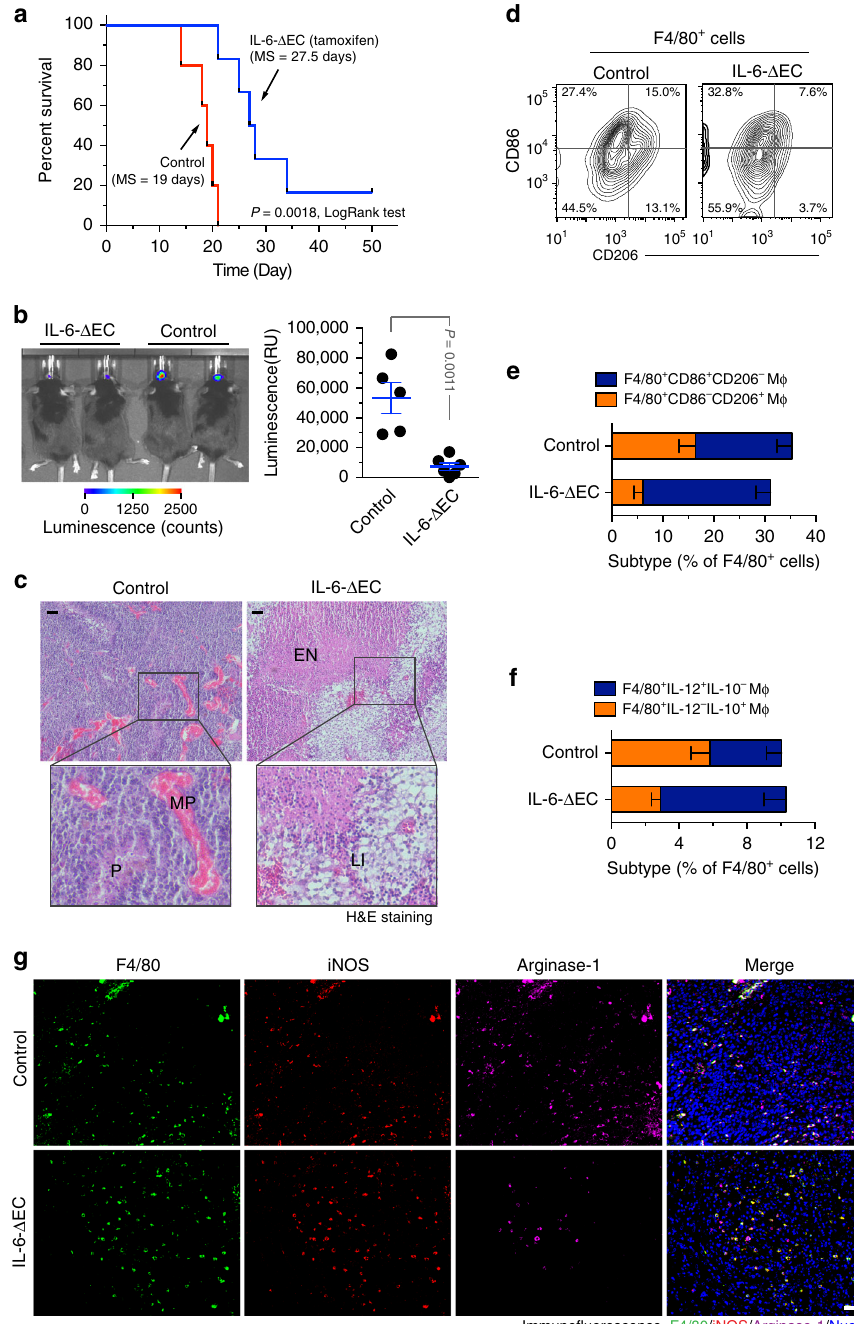
Fig. 8 Endothelial IL-6 is critical for macrophage alternative activation and GBM growth and progression. The genetically engineered GBM model was induced in Ntv-a ; Ink4a-Arf − / − ; Pten − / − ; LSL-Luc donor mice, followed by orthotopic tumor implantation into Cdh5 - Cre ERT2 ; Il6 fl / fl mice that were treated with (IL-6- Δ EC) or without (Control) tamoxifen. a Animal survival was monitored for 50 days post-injection ( n = 5 – 6 mice, one representative result from three independent experiments). P values were determined by log-rank (Mantel – Cox) tests. MS, median survival. b Tumor growth was analyzed by bioluminescence. Left, representative images. Right, quantitative analysis of integrated luminescence in tumors at day 12 (mean ± SEM, n = 5 – 6, one representative result from three independent experiments). P value was determined by Student ’ s t test. c Tumor sections were stained with hematoxylin and eosin (H&E). Representative images are shown ( n = 10 mice). P pseudopalisades, MP microvascular proliferation, EN extensive necrosis, LI leukocyte in fi ltration. Bar represents 100 μ m. Zoom-in factor: 3. e , f Tumors were excised. Single-cell suspensions were prepared and subjected to fl ow cytometry analysis. d , e Single-cell suspensions were probed with anti-F4/80, anti-CD86, and anti-CD206 antibodies. CD206 and CD86 expression were analyzed in sorted F4/80 + cells. d Representative sorting. e Quanti fi ed results (mean ± SEM, n = 10 – 14 mice). f Single-cell suspensions were probed with anti-F4/80, anti-IL-10, and anti-IL-12 antibodies. IL-10 and IL-12 expression was analyzed in sorted F4/80 + cells. Show are quanti fi ed results (mean ± SEM, n = 8 – 13 mice). g Tumor sections were stained and analyzed by immuno fl uorescence. Tumor sections were probed with anti-iNOS, anti-arginase-1, anti-F4/80 antibodies ( n = 10 mice). Bar represents 100 μ